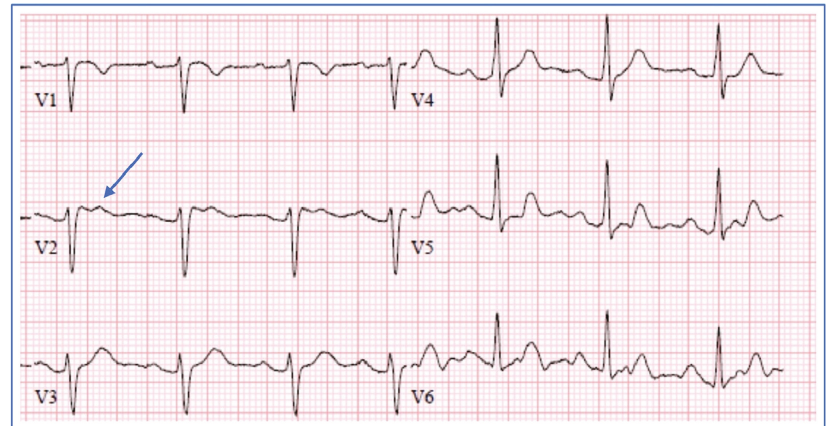
Figure 1: Patient’s ECG demonstrating type II Brugada ST-segment elevation and a “saddleback” appearance in